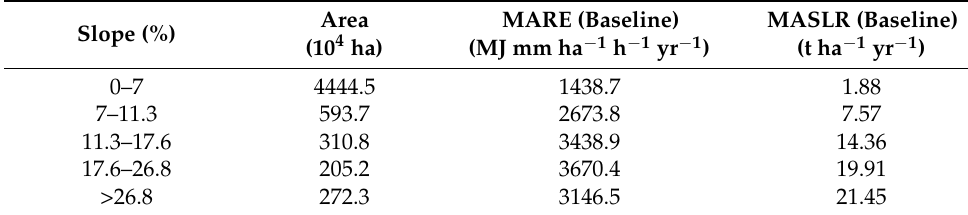
Table 10. Baseline soil erosion rates in different slope zones of Kenya.